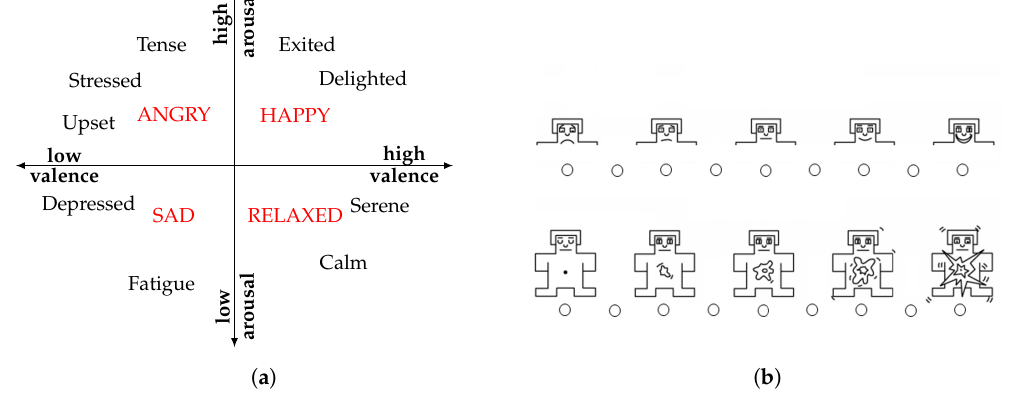
Figure 1. Exemplary dimensional model. ( a ) Schematic representation of the circumplex (valence-arousal) model. Adapted from Valenza et al. [36]; ( b ) Exemplary Self-Assessment Manikins [38], used to generate labels in the valence-arousal space. Adapted from Jirayucharoensak et al.